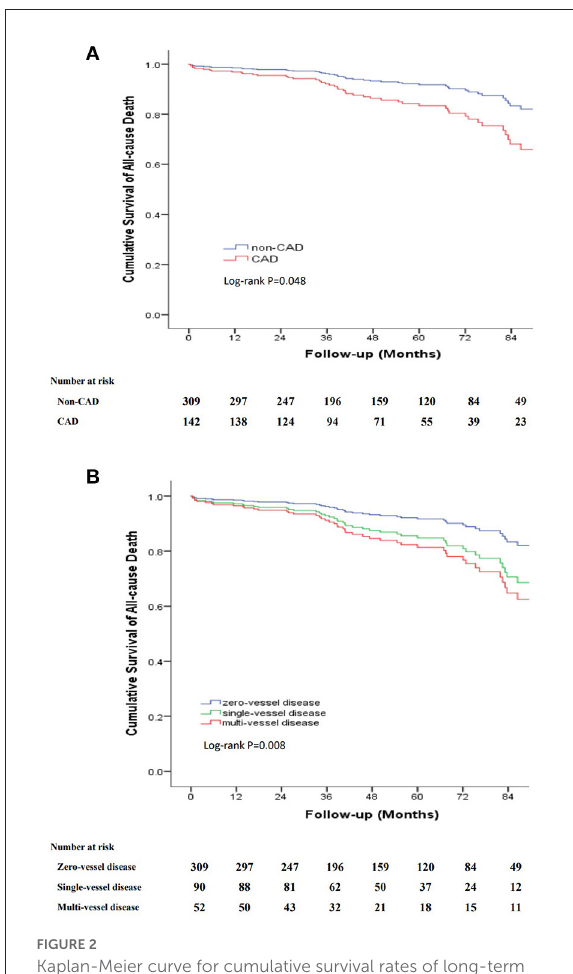
FIGURE2 Kaplan-Meier curve for cumulative survival rates of long-term mortality. (A) Classified by TBAD patients with and without CAD. (B) Classified by the number of identified stenosed coronary vessels.